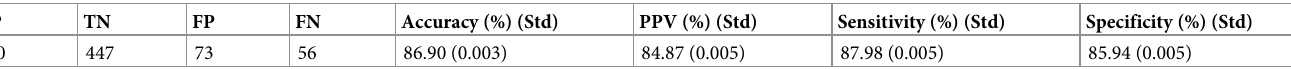
Table 3. The overall classification results across all 30 repetitions of